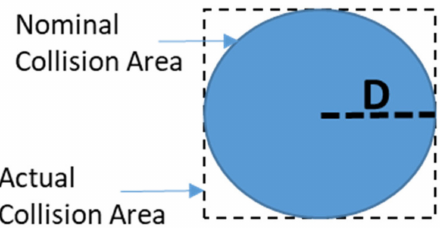
Figure 7. Approximation of the NMAC volume in the horizontal